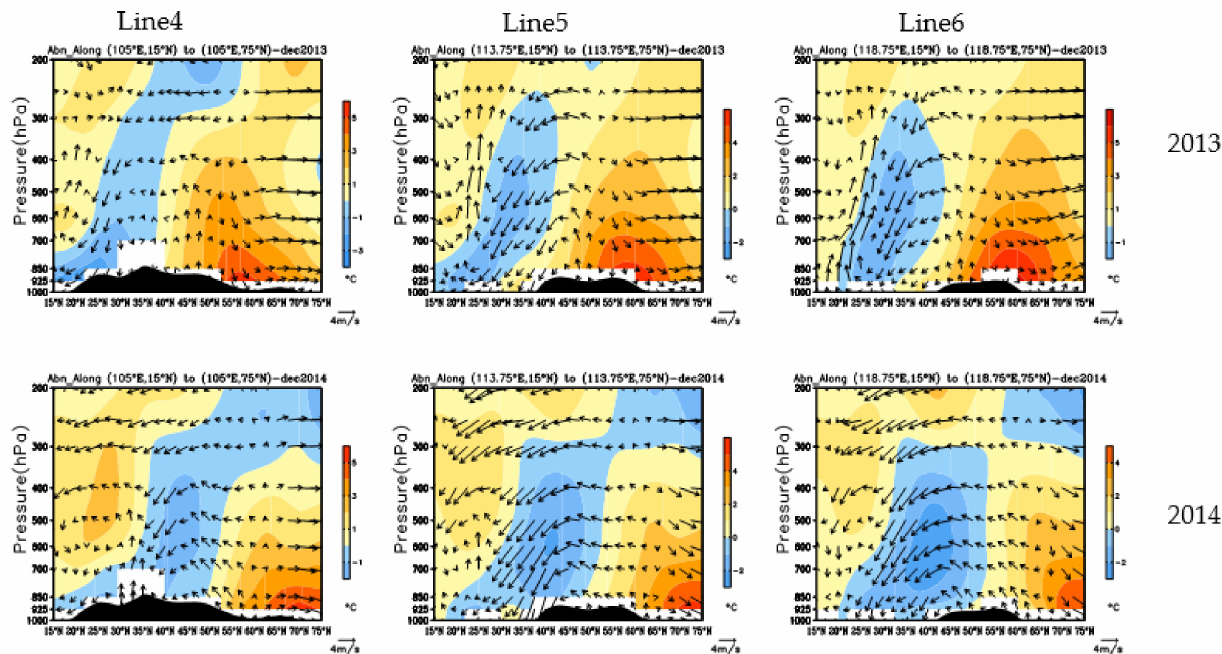
Figure 7. North–south circulation and temperature cross sections of profile 4 ( left ), profile 5 ( middle ) and profile 6 ( right ) in the 2013 ( top ) and 2014 ( bottom ) strong cold source–strong winter mon- soon years.